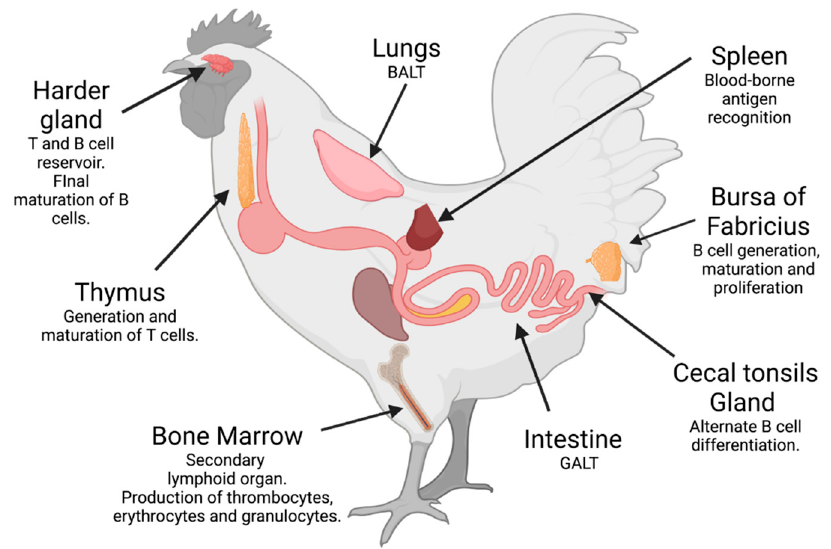
Figure 1. Organs of the immune system of birds and their functions, including the mucous-associated lymphoid tissues (MALTs), named the gut-associated (GALTs) and the bronchus-associated lymphoid tissues (BALTs). Created with BioRender.com (accessed on 8 August 2022).